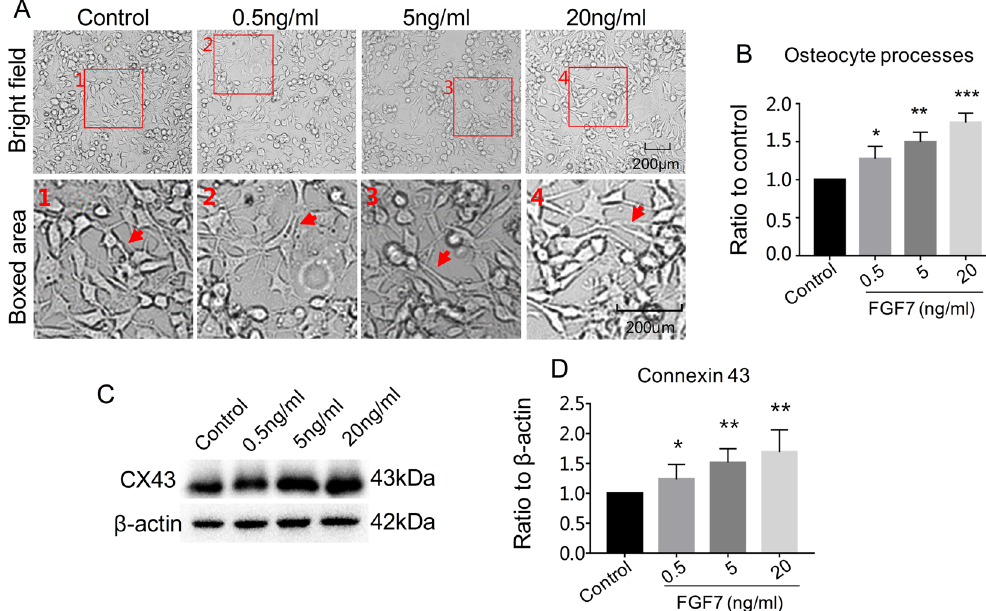
Figure 3. FGF7 induced the morphology of the osteocytes to a more stellate shape, increased the expression of connexin43 in a concentration-dose dependent manner. ( A ) Cell morphologies after FGF7 induction at the concentration of 0.5, 5, 20 ng/ml for 24 h and the red arrows showed the increased osteocyte cell processes in the higher magnification of the boxed area. ( B ) Quantitative analysis of the number of osteocyte processes of ( A ) with Image-J software 6.0. Data were means of three independent experiments (n = 3); Significant difference with respect to control, * P < 0.05, ** P < 0.025, *** P < 0.001. ( C ) Western blots showed connexin43 expressions after FGF7 induction increased in a concentration-dose (0.5, 5, 20 ng/ml) dependent manner. The cell lysates were collected at 48 h following FGF7 treatments for connexin43 and beta-actin; the images were collected from two gels with the same loading amounts. The blot gels shown are representatives of three independent experiments (n = 3). ( D ) Quantitative analysis of western blots of ( C ) with Image-J software 6.0. Data were means of three independent experiments (n = 3); Significant difference with respect to control. * P < 0.05, ** P <